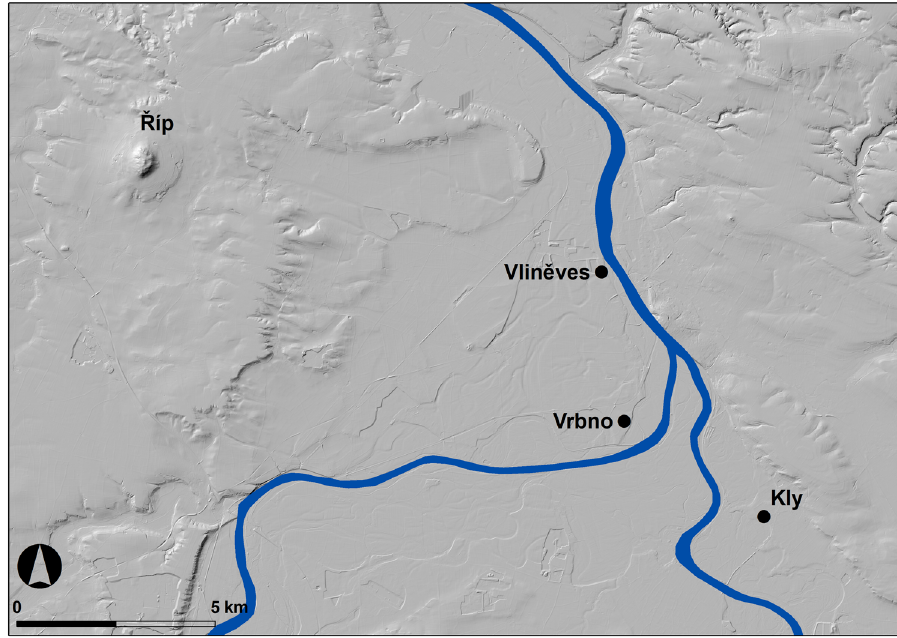
Figure 6: Terrain relief model of the M ě lník area with highlighted causewayed enclosures in the area of the Elbe and Vltava river con fl uence, in direct visibility of the Ř íp Mount ( after Kri š tuf et al., 2019, Figure 6.1 )